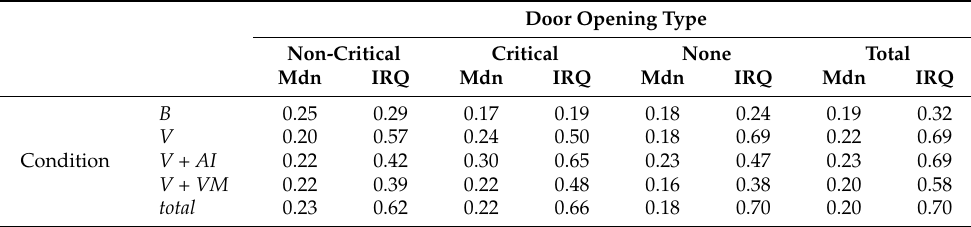
Table 2. Descriptions of the SDLP measurements during active AMs. For B , we considered the time frames where a warning would be triggered when an AM system would have been used. Unit: [m].